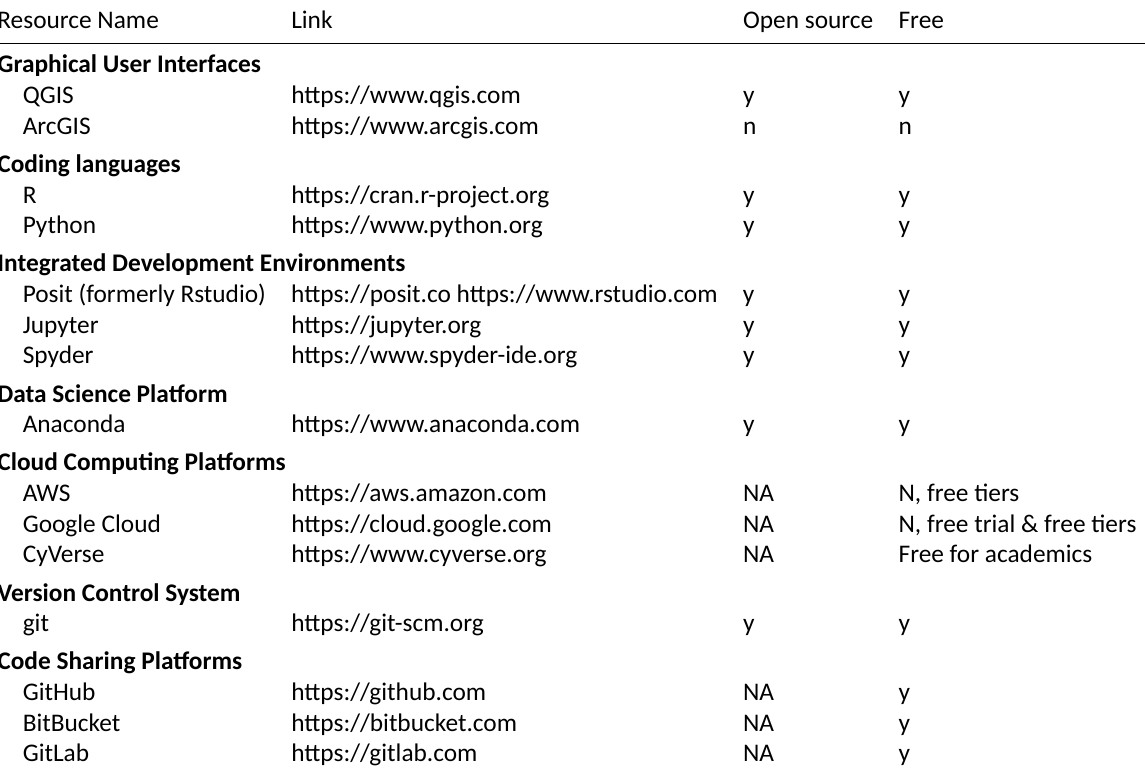
Table 3: Software